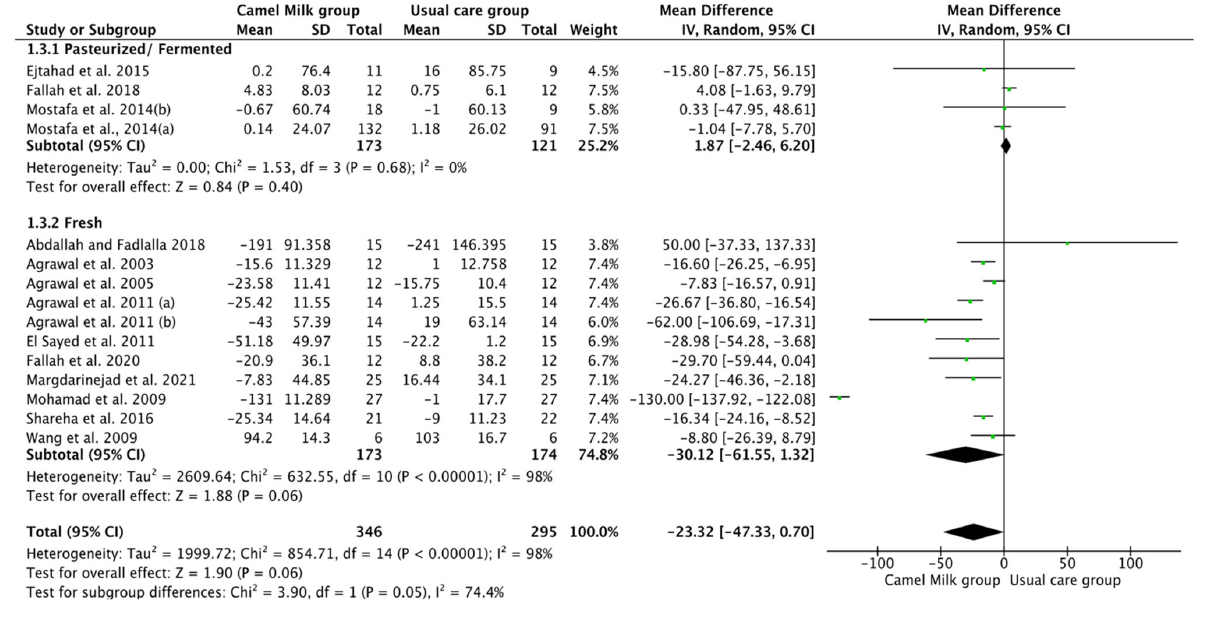
Figure 12. Forest plot for the effect of CM intake on FBG levels based on the type of CM. Note: Mostafa and Al-Musa, 2014 (a) for T1DM and (b) for T2DM. Table 3. Subgroup analyses for the different moderators related to the effect of CM intake on two glycemic control parameters (FBG and HbA1c) in patients with diabetes.